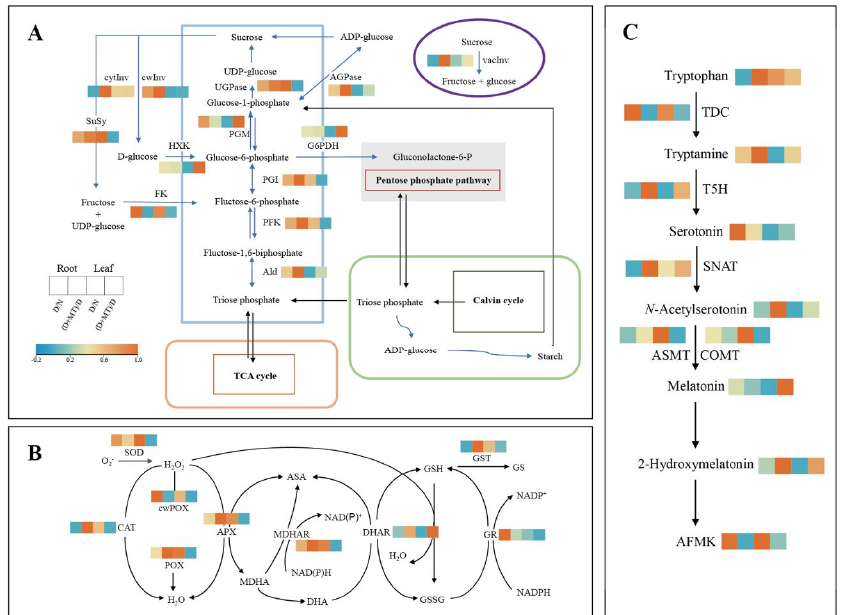
Figure 2. Metabolite concentrations and activities of enzymes involved in metabolisms of reactive oxygen species, carbohydrate, and melatonin in root and leaf as affected by melatonin treatment and drought stress in barley. ( A ) Change in carbohydrate metabolism enzyme activities. ( B ) Change in antioxidant enzyme activities. ( C ) Change in melatonin metabolism enzyme activities and concentrations of related metabolites. The difference of concentration/activity for a given metabolite/enzyme between the normal control (N) and treatments is normalized and converted to a color scale. An increase and decrease in concentration/activity are indicated in red and blue, respectively. N, normal control; D, drought stress; D + MT, melatonin + drought stress. SOD, superoxide dismutase; cwPOX, cell wall peroxidase; CAT, catalase; POX, peroxidase; APX, ascorbate peroxidase; MDHAR, monodehydroascorbate reductase; DHAR, monodehydroascorbate; GR, glutathione reductase; GST, glutathione S-transferase; cytInv, cytoplasmic invertase; vacInv, vacuolar invertase; cwInv, cell wall invertase; UGPase, UDP-glucose pyrophosphorylase; Susy, sucrose synthase; HXK, hexokinase; G6PDH, glucose-6-phosphate dehydrogenase; PGI, phosphoglucoisomerase; FK, fructokinase; PFK, phosphofructokinase; PGM, phosphoglucomutase; AGPase, ADP-glucose pyrophosphorylase; Ald, aldolase; T5H, Tryptamine 5-hydroxylase; AFMK, N 1 -acetyl- N 2 -formyl-5-methoxyknuramine; TDC, Tryptophan decarboxylase; SNAT, Serotonin N -acetyltransferase; ASMT, N -acetylserotonin methyltransferase; COMT, caffeic acid, O -methyltransferase.